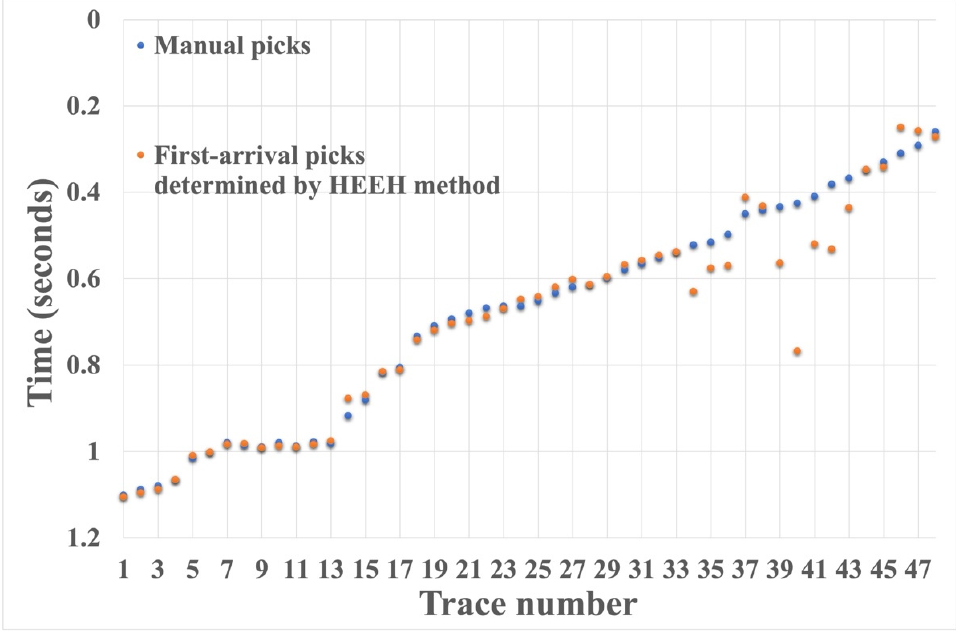
Figure 11. Yilmaz record number 22 first arrival picks determined by the HEEH method and man- ually.